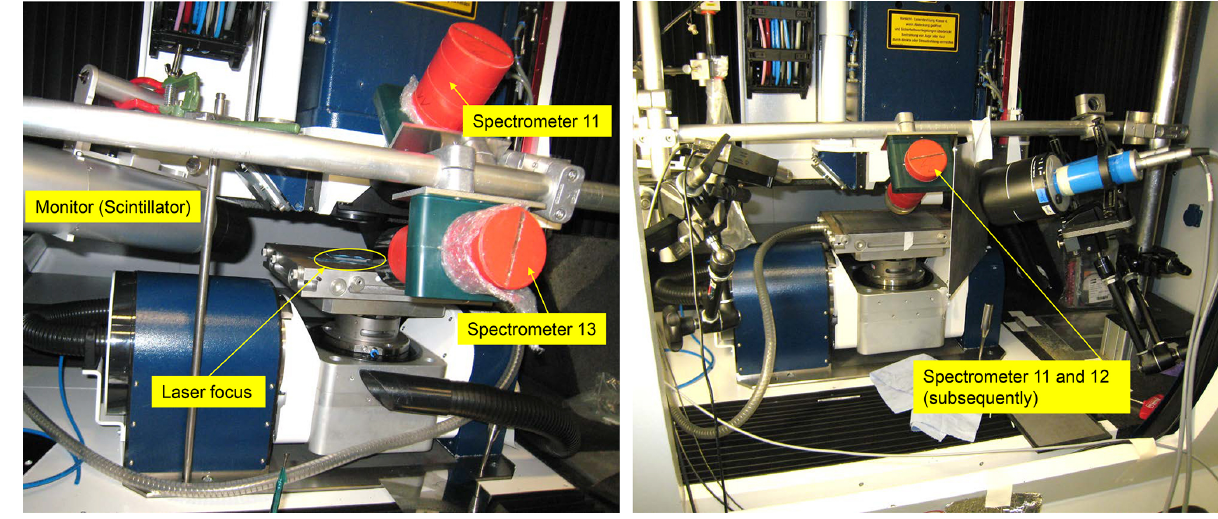
Figure 2. Experimental setup of the two performed measurement